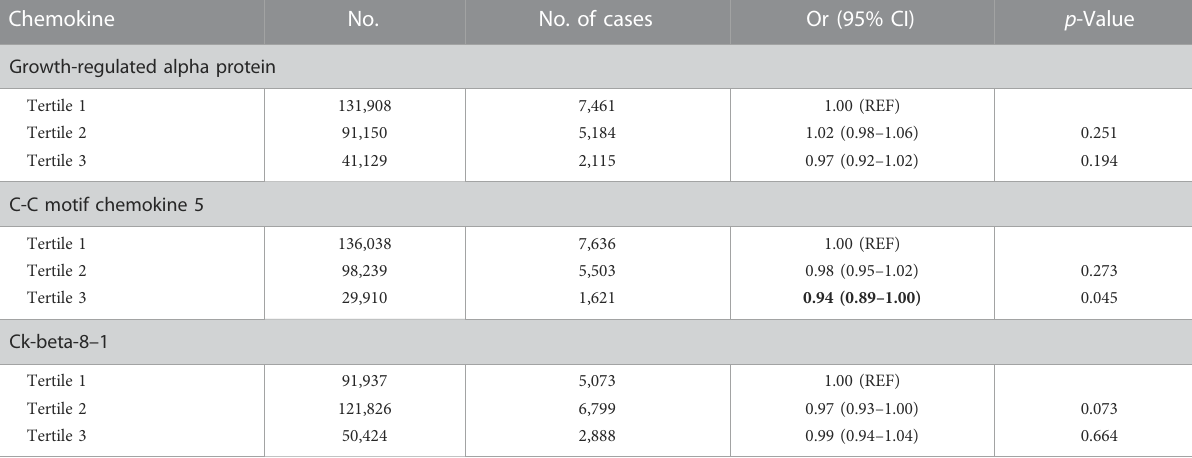
TABLE 1 The association between polygenic risk scores for chemokines and breast cancer in the UK Biobank. Chemokine